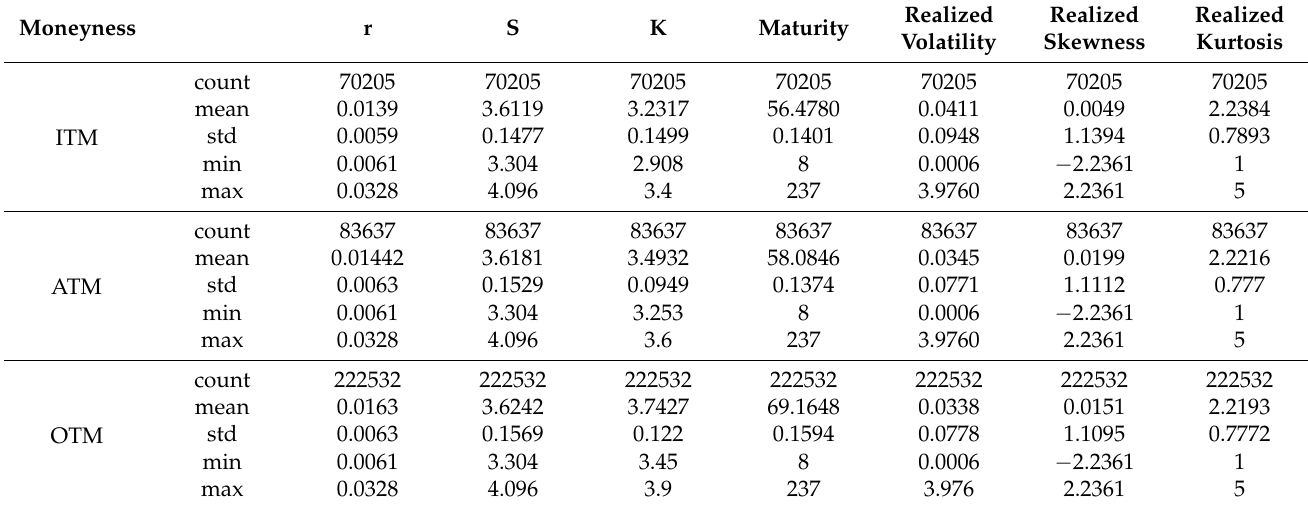
Table 3. Statistics of ETF50 Call options sorted by moneyness.